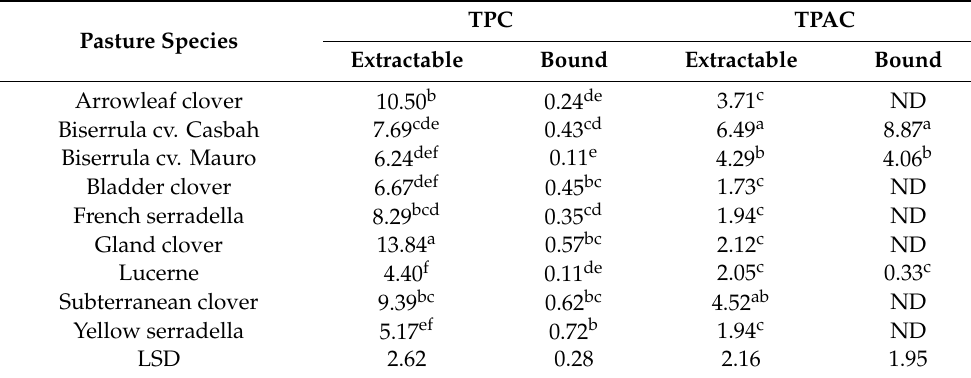
Table 3. Concentration of extractable and bound total polyphenol and total proanthocyanidins in foliar tissues of pasture